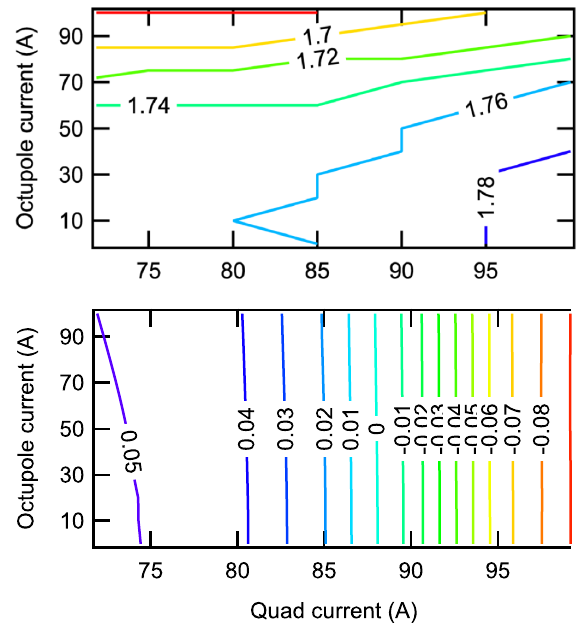
gradient error, at two quadrupole currents. The simulations relative discrepancies in the range of 10 − 4 .